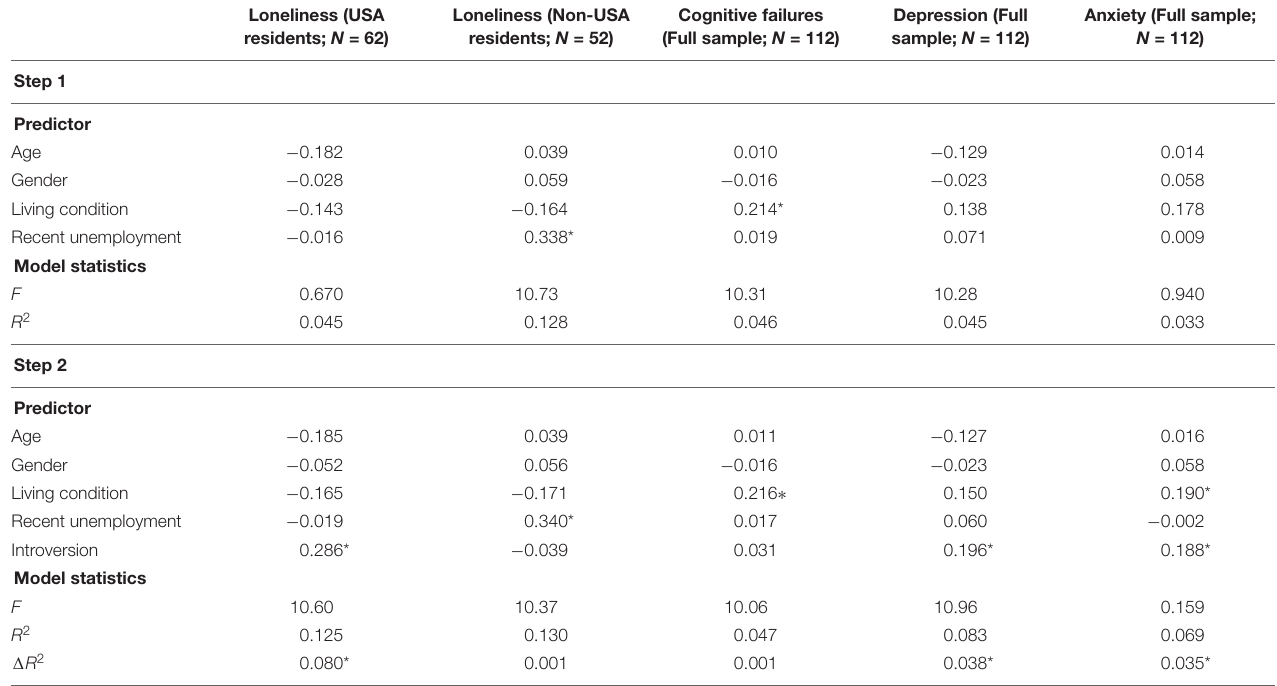
TABLE 2 | Standardized β coefficients for predictor variables (and associated model statistics) in hierarchical regression analyses predicting the psychological impact of COVID19-related circumstantial changes, across psychosocial, cognitive, and affective domains. Loneliness (USA Loneliness (Non-USA Cognitive failures Depression (Full Anxiety (Full sample; residents; N = 62) residents; N = 52) (Full sample; N = 112) sample; N = 112) N =